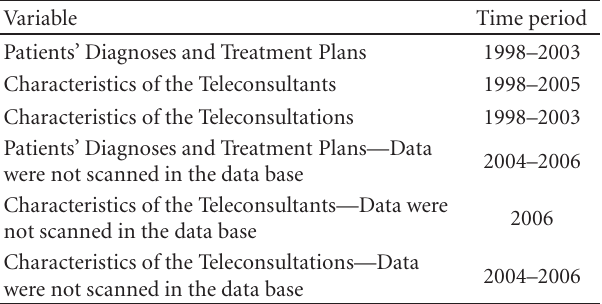
Table 1: Time periods for data collection in the UAMS Rural Hospital, Telehealth